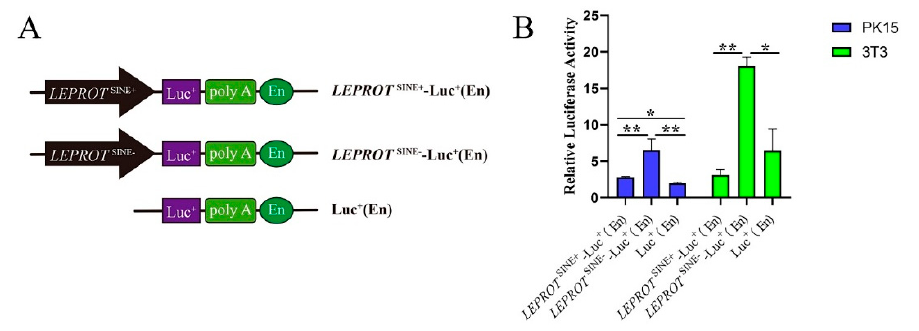
Figure 3. SINE insertion served as a repressor to affect the promoter of LEPROT . ( A ) Schematic diagram of the recombinant vector structure. ( B ) The results of promoter activity verification. * showed p < 0.05; ** showed p < 0.01.